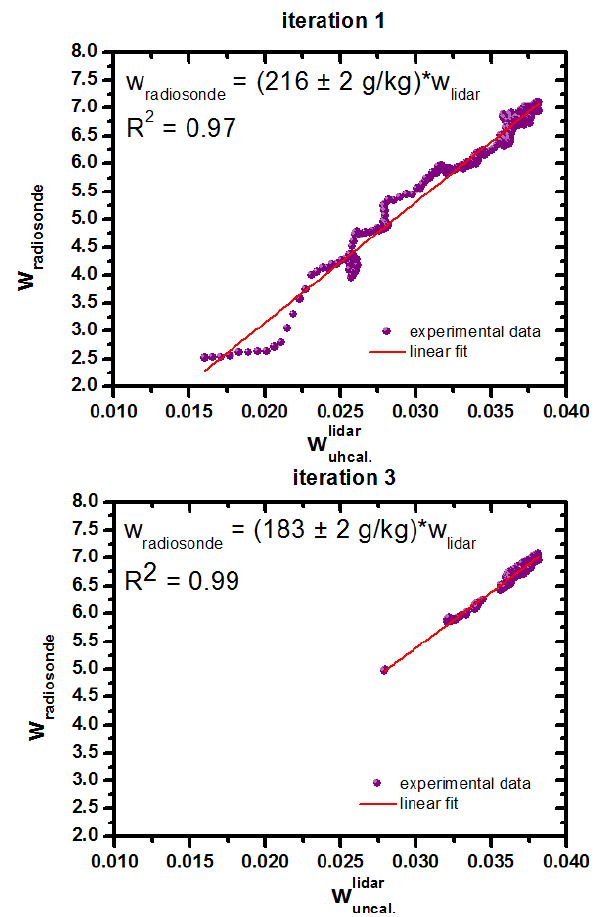
Fig. 1. Iterative procedure of linear regressions to retrieve lidar cal- ibration constant from the comparison of lidar and radiosonde data: (top) regression for the first iteration, (bottom) final regression (it- eration 3).